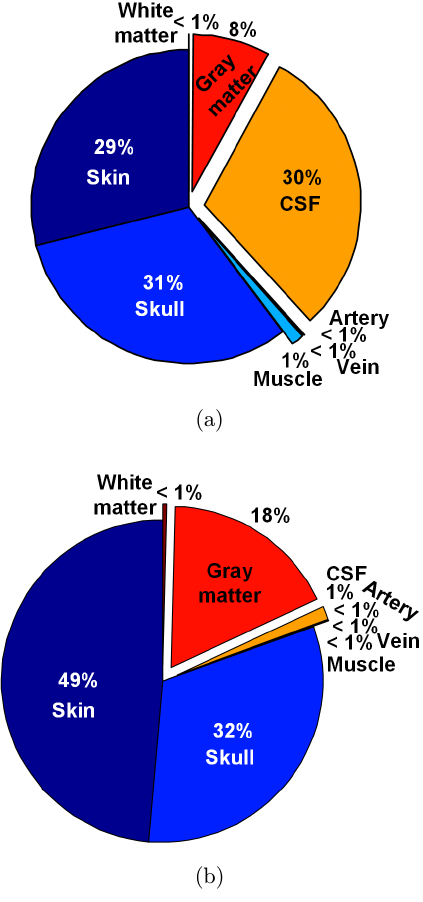
Fig. 4. Pie of SSD in each tissue layers in VCH (a) and Zubal MRI (b) head models,